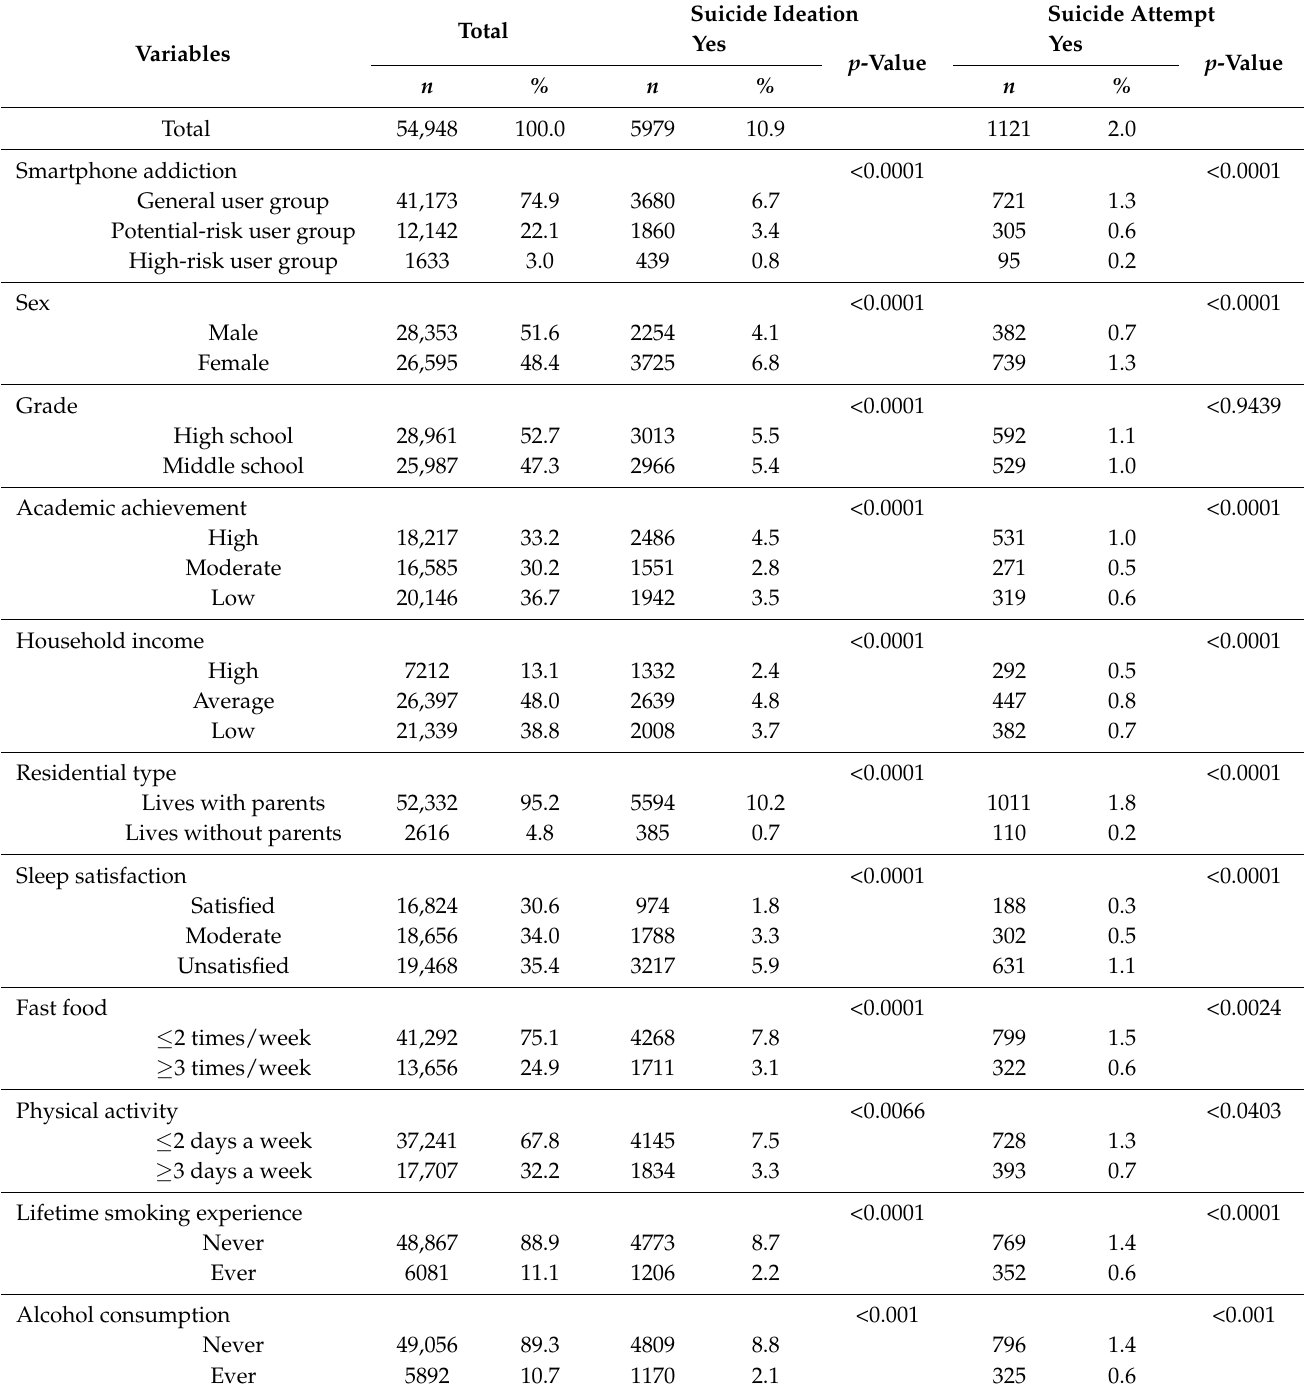
Table 2 indicates the general characteristics of the participants. Adolescents who experienced suicidal ideation within the last 12 months included 5979 (10.9%) of 54,978 participants. By category, 3680 (6.7%) adolescents in the general user group, 1860 (3.4%) in the potential-risk group, and 439 (0.8%) in the high-risk group experienced suicidal ideation in the last 12 months. Table 2. Bivariate association between smartphone addiction and suicide ideation and suicide attempt of study